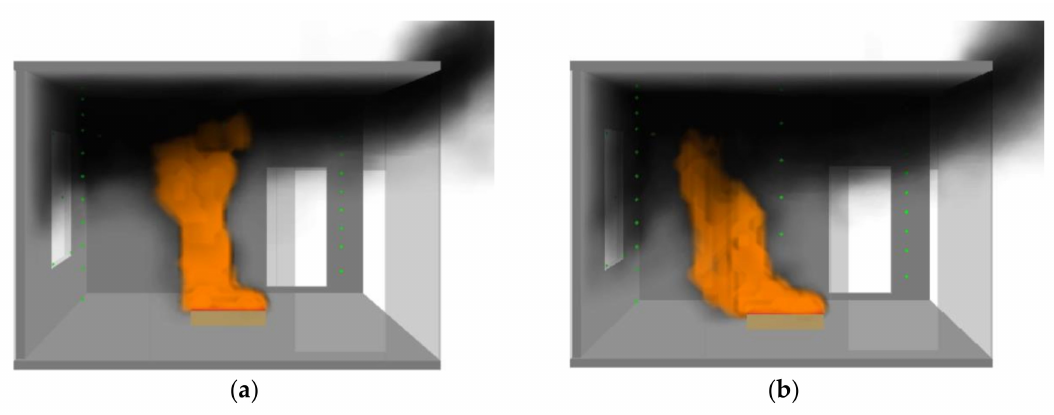
Figure 13. Smoke distribution under window sprinkler conditions: ( a ) 50 s, ( b ) 150